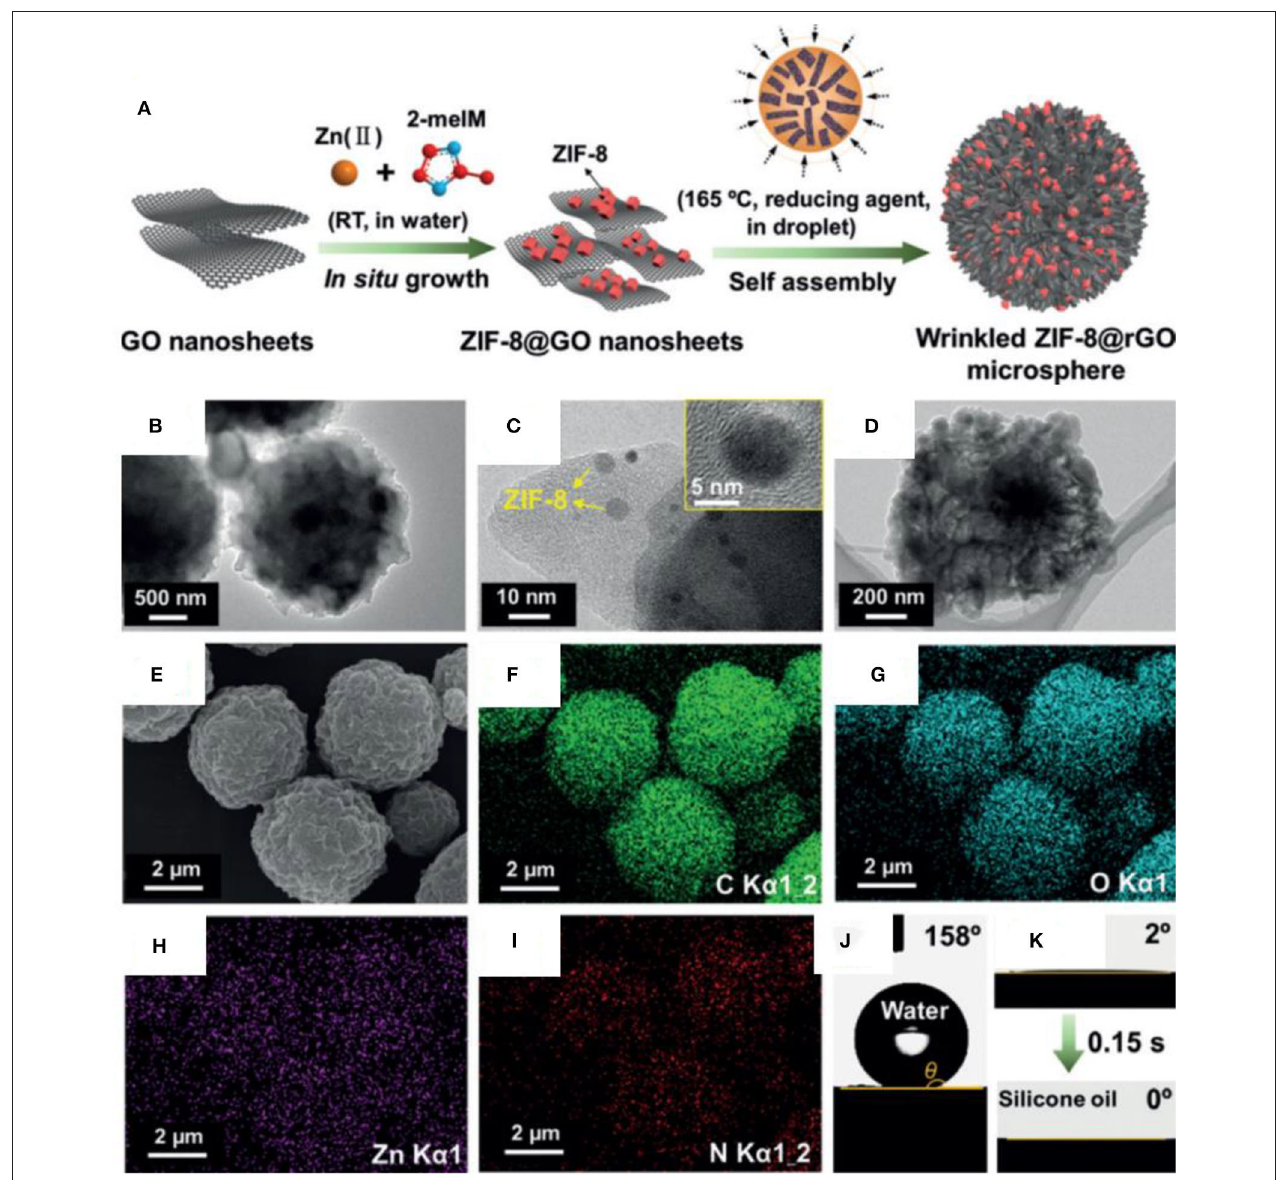
FIGURE 10 | (A) Schematic showing the formation process of ZIF-8@rGO spheres. (B–D) Transmission electron microscopy (TEM) images showing the structure of the wrinkled ZIF-8@rGO. (E) SEM and (F–I) energy-dispersive spectrometry (EDS) of ZIF-8@rGO. (J) Contact angle of water and (K) silicone oil on ZIF-8@rGO (Gu et al.,